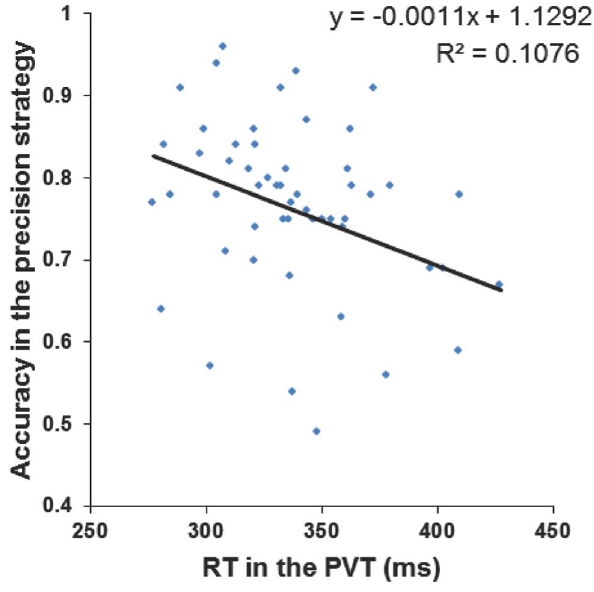
Figure 4. Correlation between RT in the PVT and accuracy on SART for the precision strategy